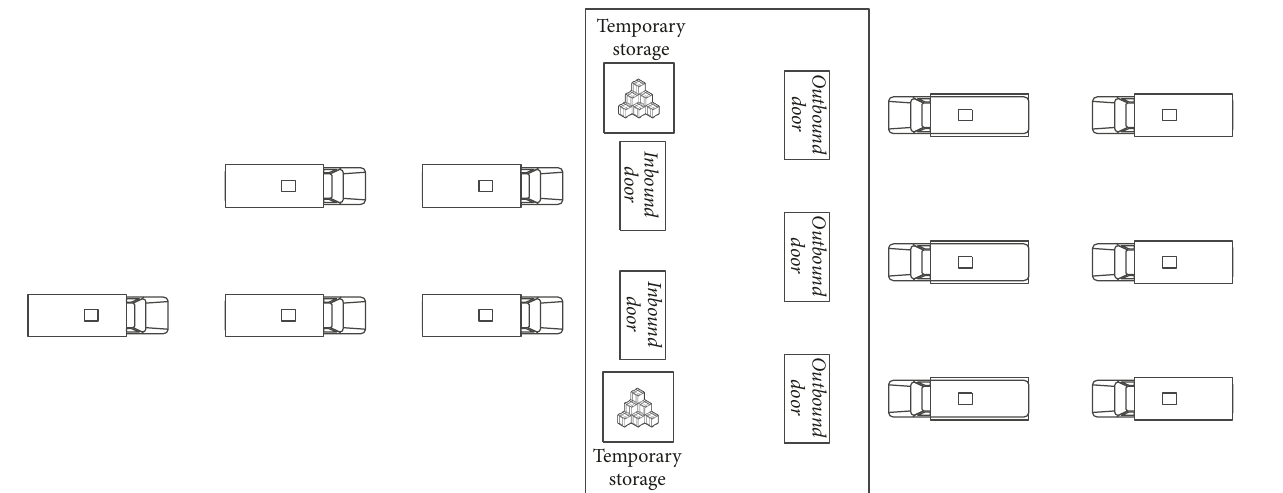
Figure 1: The layout of cross-docking